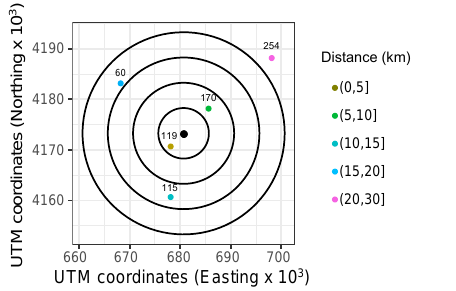
Figure 9. Case example: distribution of points selected and the forecasting point marked in black color (UTM